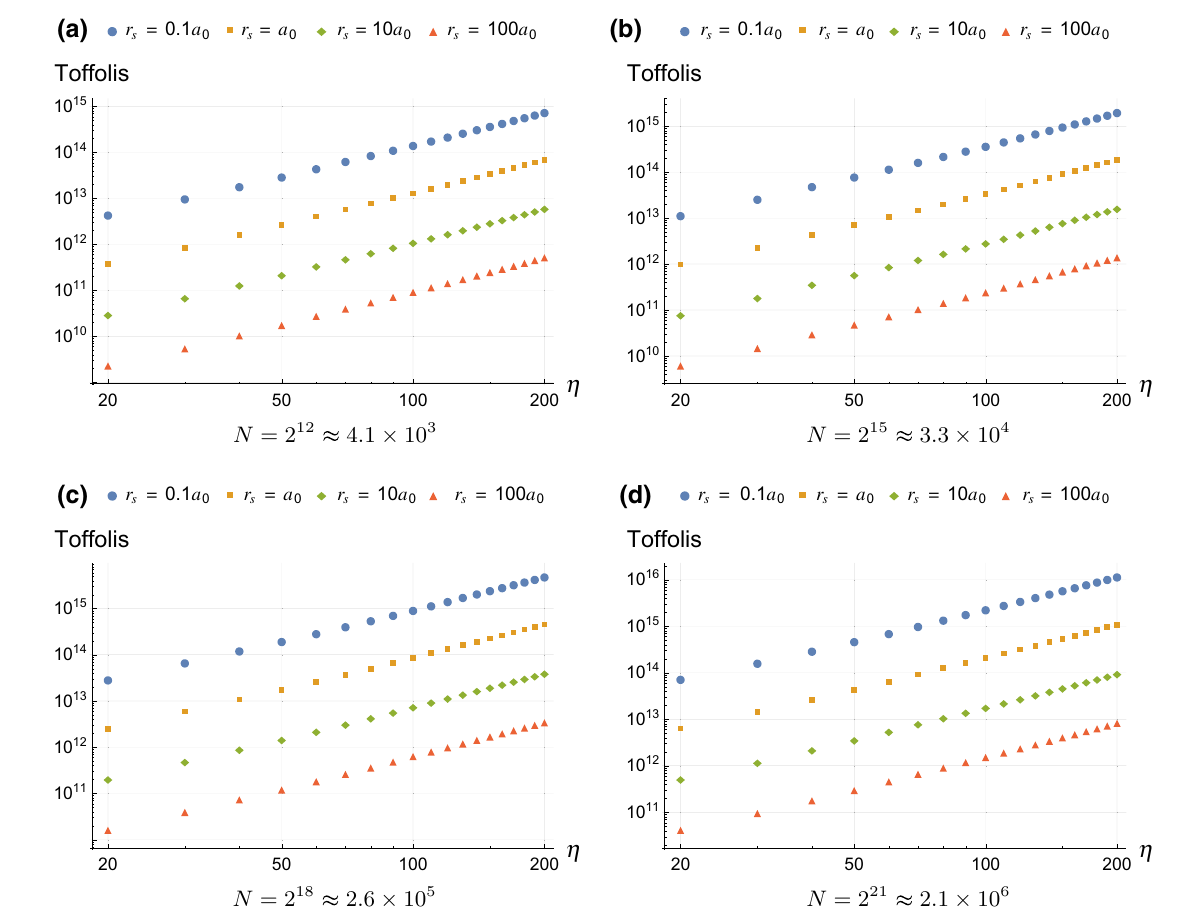
FIG. 4. Toffoli count of interaction-picture algorithm as a function of η using improved techniques. In contrast to Fig. 1, we plot these costs for fixed values of the Wigner-Seitz radius r s to give a sense of the scaling when η increases proportionally to (cid:10) (as would be the case when growing condensed phase simulations towards their thermodynamic limit). Thus, we expect these plots to be representative of costs when simulating periodic materials. We see that the scaling depends rather weakly on the number of plane waves, N